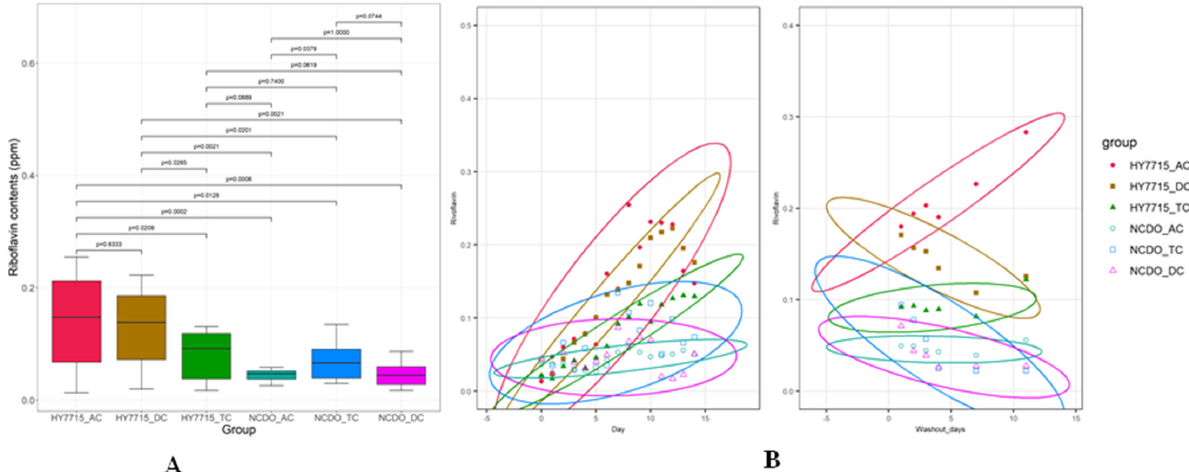
Figure 3. Graph of riboflavin concentration change according to HY7715 and NCDO1752 treatment days. ( A ): Boxplot of riboflavin concentration on treatment days (0–14 days) for each analyzed colon section. Statistical analysis was performed using the Kruskal–Wallis nonparametric test. ( B): Increase/decrease trend graph with changes in the riboflavin concentration by treatment species, site, and date in the washout stage (right). Only HY7715 showed an increasing trend.